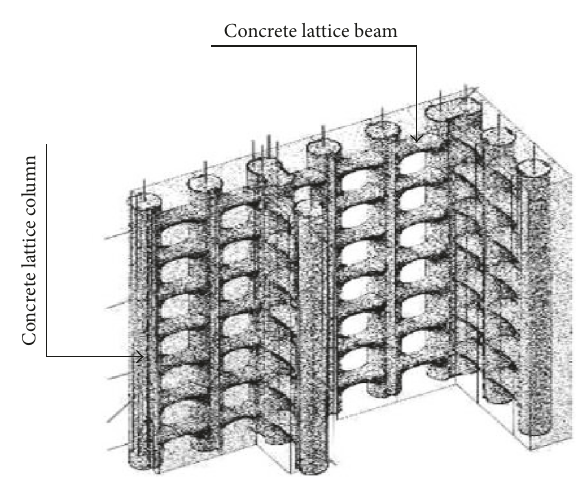
Figure 1: EPSC latticed concrete wall.